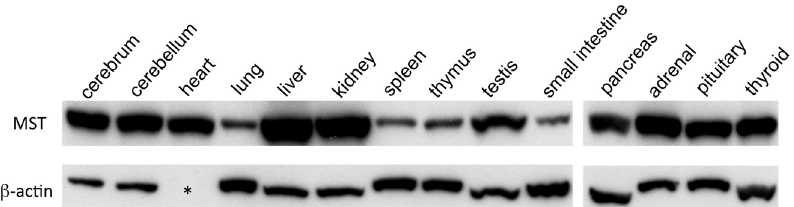
Figure 1. MST expression in various organs of mice by Western blotting. MST expression in the cerebrum, cerebellum, heart, lungs, liver, kidneys, spleen, thymus, testes, small intestines, pancreas, adrenal, pituitary, and thyroid glands; β -actin is not detected in the heart (asterisk).